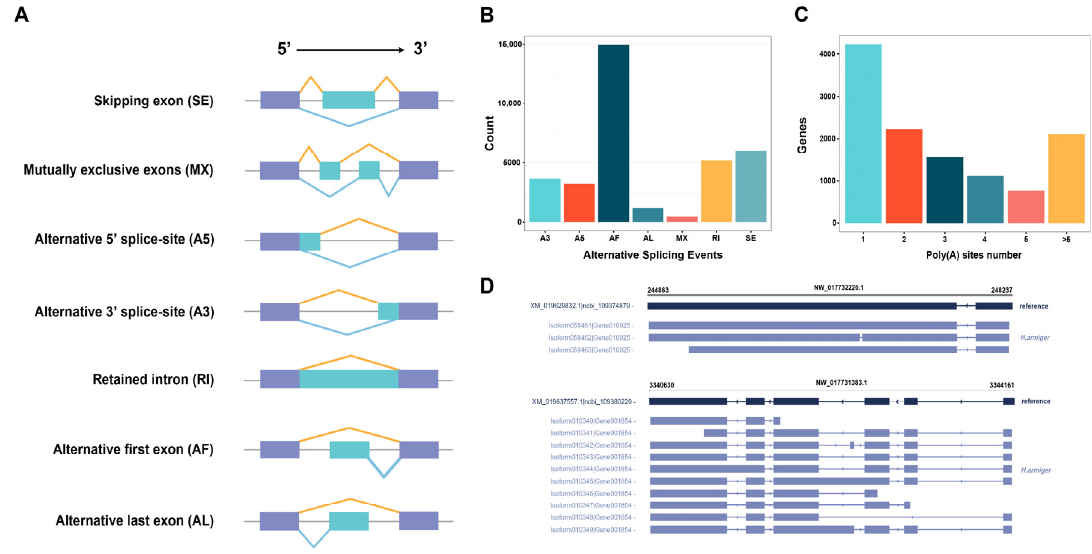
Figure 8. AS and APA analysis of H. armiger full ‐ length transcriptome. ( A ) Seven major AS events. ( B ) Number and categories of the AS events identified. ( C ) Distribution of the number of poly (A) sites per gene. ( D ) Two examples for the isoforms generated by the same gene (XM_019629832.1 ( TIGD2 ) and XM_019637557.1 ( ACTB ), respectively). The transcripts in the reference genome of H. armiger and PacBio were respectively marked with dark blue and purple color. The gray horizontal line and the text above showed the chromosome ID, start, and end position of the terminal gene